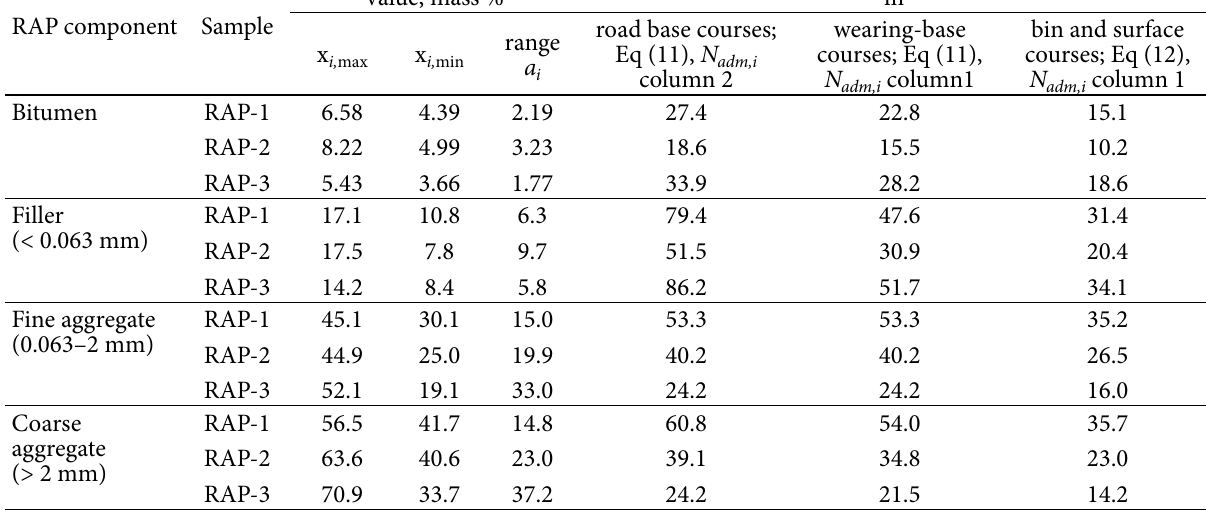
Table 4 . The most content of RAP (percentage mass) allowed for proportion in recycled HMA mixtures corresponding to RAP homogeneity by its componential structure and the type of asphalt